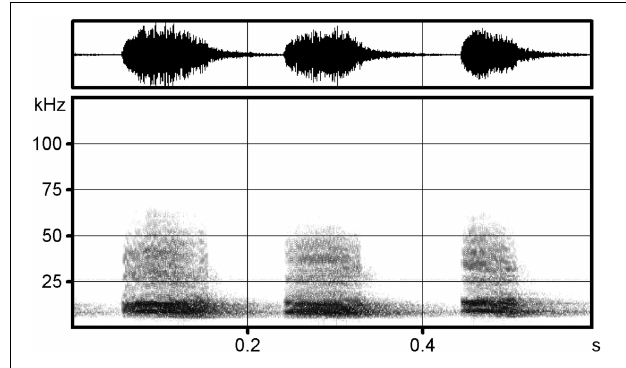
FIGURE 1 | Spectrogram showing elements from a typical Brachyphylla nana distress call (FFT = 512, Hamming Window, 50%